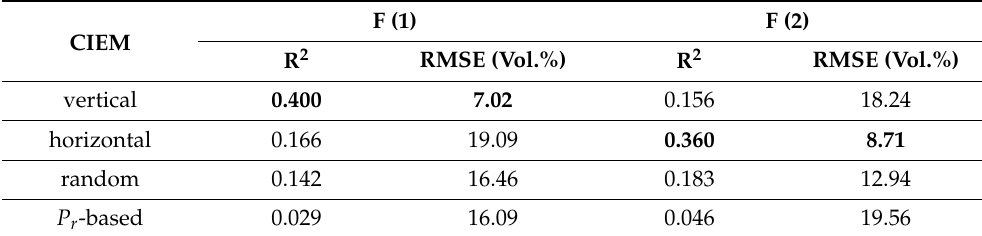
Table 3. Estimation results using CIEM